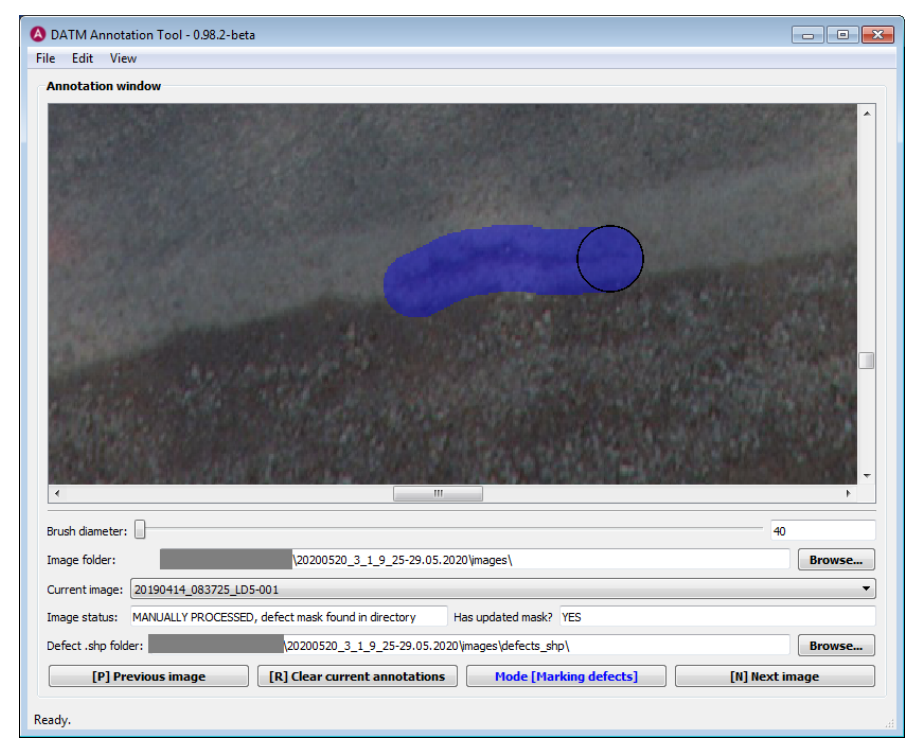
Figure 12. Graphical user interface of the annotation tool written in Python 3 with the PyQt